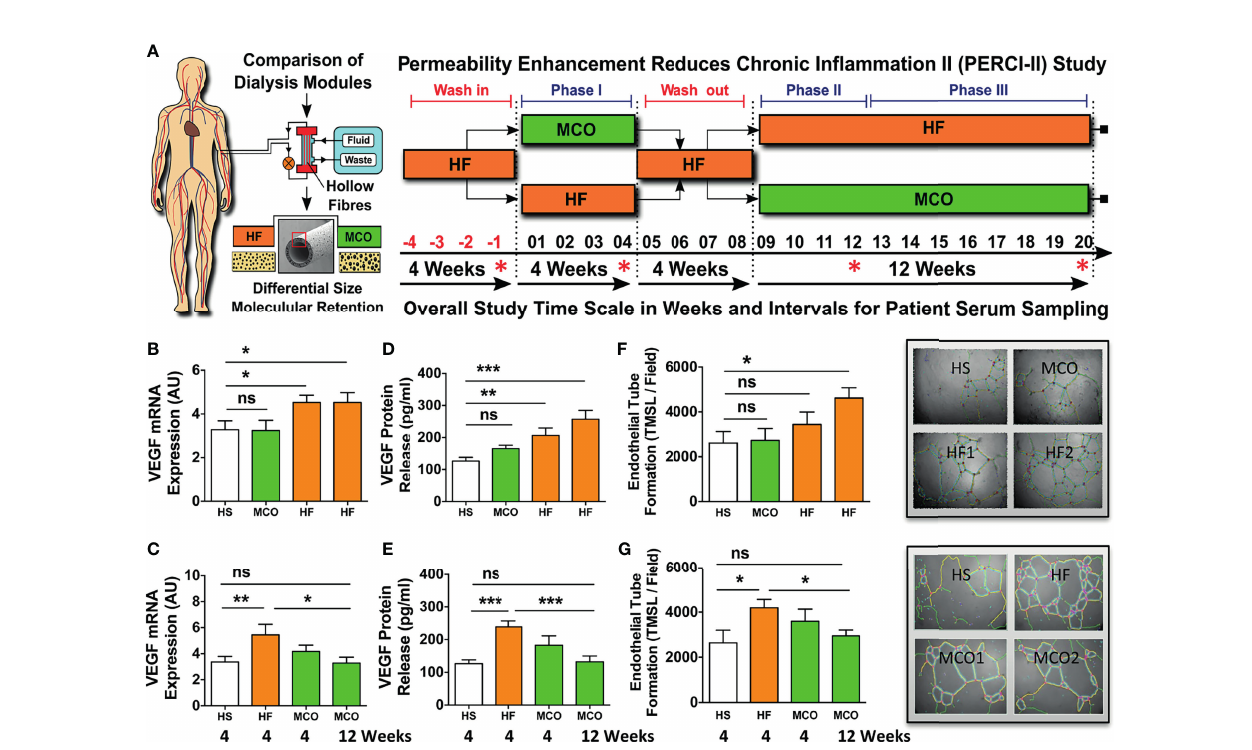
FIGURE 2 | Hemodialysis with improved MCO dialyzers normalizes endothelial VEGF production and maladaptive angiogenesis upon uremic serum exposure in vitro . (A) Schematics of patient serum collection for analysis of endothelial VEGF expression and angiogenesis/endothelial tube formation after stimulation of ECs with respective sera. Within the PERCI-II study, patients underwent alternating hemodialysis (HD; in 4 weeks intervals) with either high- fl ux (HF) or medium cut-off (MCO) dialyzers (n=23-25 patients). Upon a 4-weeks wash-in phase on HF dialyzers, patients were allocated for 4 weeks to either HF or MCO dialyzers, followed by a 4- weeks wash-out phase on HF dialyzers, followed by a 12-weeks allocation to HF or MCO dialyzer. The top row shows regimen A (HF, MCO, HF, HF) and the bottom row shows regimen B (HF, HF, MCO, MCO). The sera/time points used for analysis in the second part of the fi gure are indicated with red stars: end of wash- in, end of phase 1, 2, 3; and (B, C) Endothelial VEGF mRNA expression (AU; arbitrary units, 3-hour stimulation; n=23-25), and (D, E) VEGF protein release (pg/ml) upon 24-hour stimulation with either 10% HF-HD or 10% MCO-HD serum (n=23-25), and (F, G) Endothelial tube formation (TMSL/ fi eld; n=23-25) upon stimulated with either 10% HF-HD or 10% MCO-HD serum for 16 hours, as compared to healthy serum (HS) controls. ANOVA, Mean ± SEM, with * P < 0.05, ** P < 0.01, and *** P < 0.001. ns, not signi fi